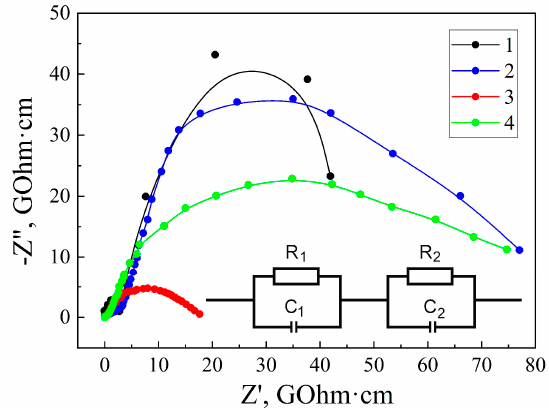
Figure 5. Nyquist diagrams measured for the matrix MSM-41 (1) and encapsulate MSM-41<SFA> under normal conditions (2), in a magnetic field (3), and under illumination (4).